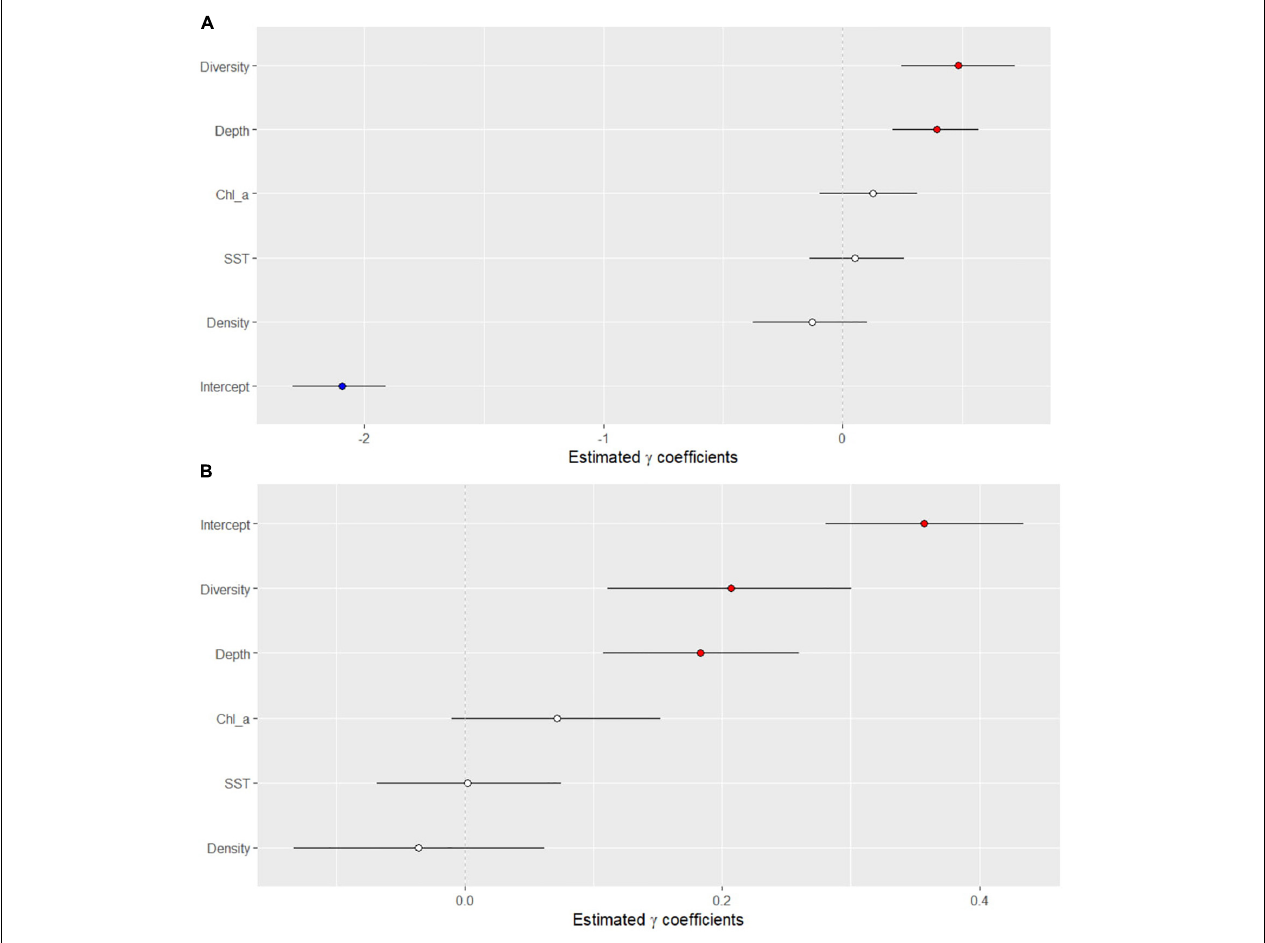
FIGURE 5 | Results of the Bayesian negative binomial generalized linear mixed effects model that tested the association of several ecological and environmental parameters on the (A) presence/absence of the stony-coral-tissue-loss disease and (B) density of diseased corals along the Florida reef tract from 2014 to 2017. Horizontal black lines indicate 95% credible intervals of the posterior distributions of each variable. Values above zero indicate a significant association between the variable and the presence/absence of